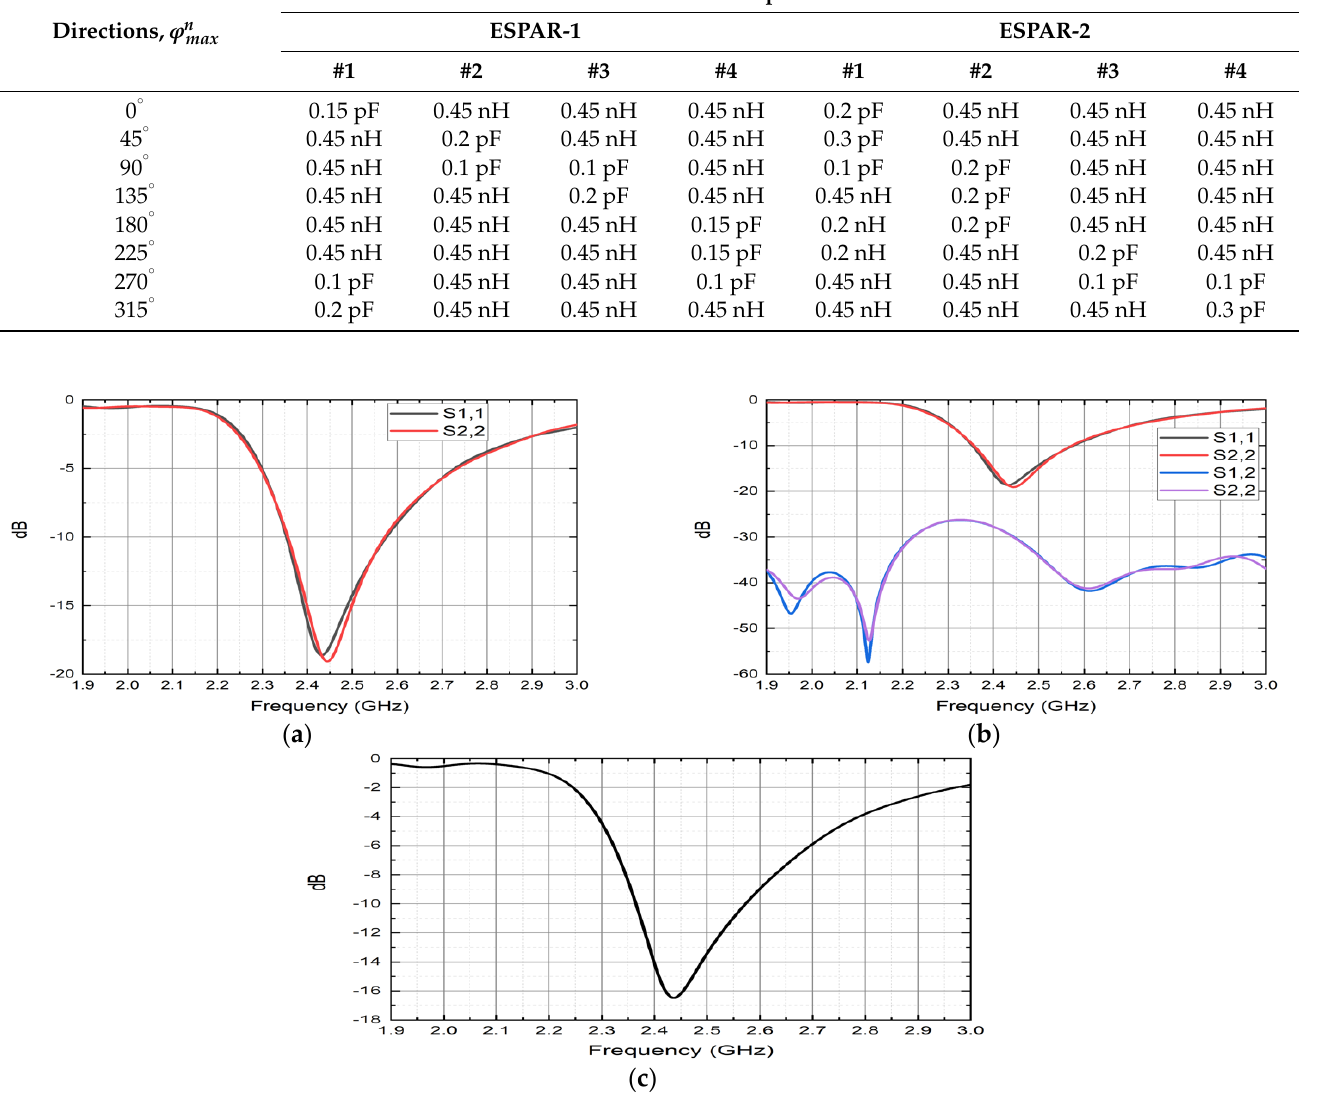
Figure 7. ( a ) Reflection coefficients of S1,1 and S2,2; ( b ) complete reflection coefficient during ϕ 6 max = 225 ◦ ; ( c ) reflection coefficient after far-field combination. Table 4. Reactance set of the proposed 1 × 2 ESPAR array antenna.